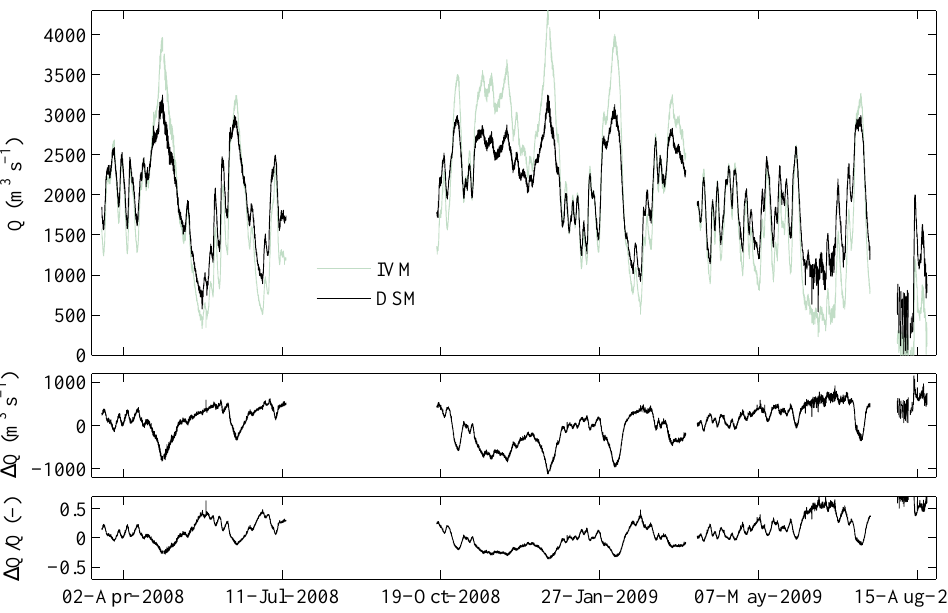
Fig. 10. Continuous series of discharge estimates derived from H-ADCP data with the DSM and the IVM. Central and bottom panels offer a comparison between DSM and the IVM to convert H-ADCP data to discharge, where 1Q = Q DSM − Q IVM .